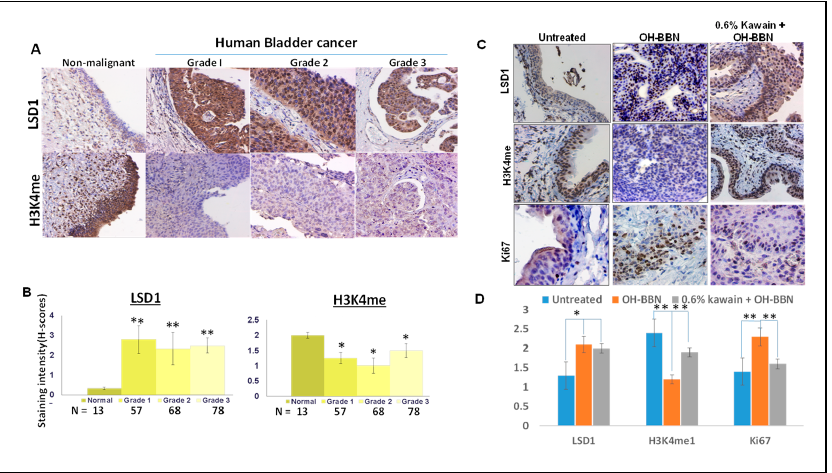
Figure 4. LSD1 is overexpressed and H3K4me level is downregulated in both human and mouse bladder cancer tissues compared to normal bladder urothelium. ( A ) LSD1 and H3K4 me expressions were examined by IHC in human normal bladder tissues and different grades of bladder cancer tissues. Magnification × 200. ( B ) The staining intensity is scored as 0, 1, 2, or 3, which correspond to negative, weak, moderate, or strong staining intensities, respectively. Percentages of stained cells are determined by counting at least 100 cells, and a final H-score is calculated as the product of staining intensities (0–3) and percentages of stained cells (0–100%). ( C ) LSD1, H3K4me, and Ki-67 expressions were examined by IHC in bladder tissues from mice treated with a control diet, OH-BBN only, and OH-BBN plus the kawain diet. Magnification × 200. ( D ) Quantitative analysis of staining intensities (H-score). Error bars are standard errors. “*” denotes p < 0.05 and “**” p < 0.01.